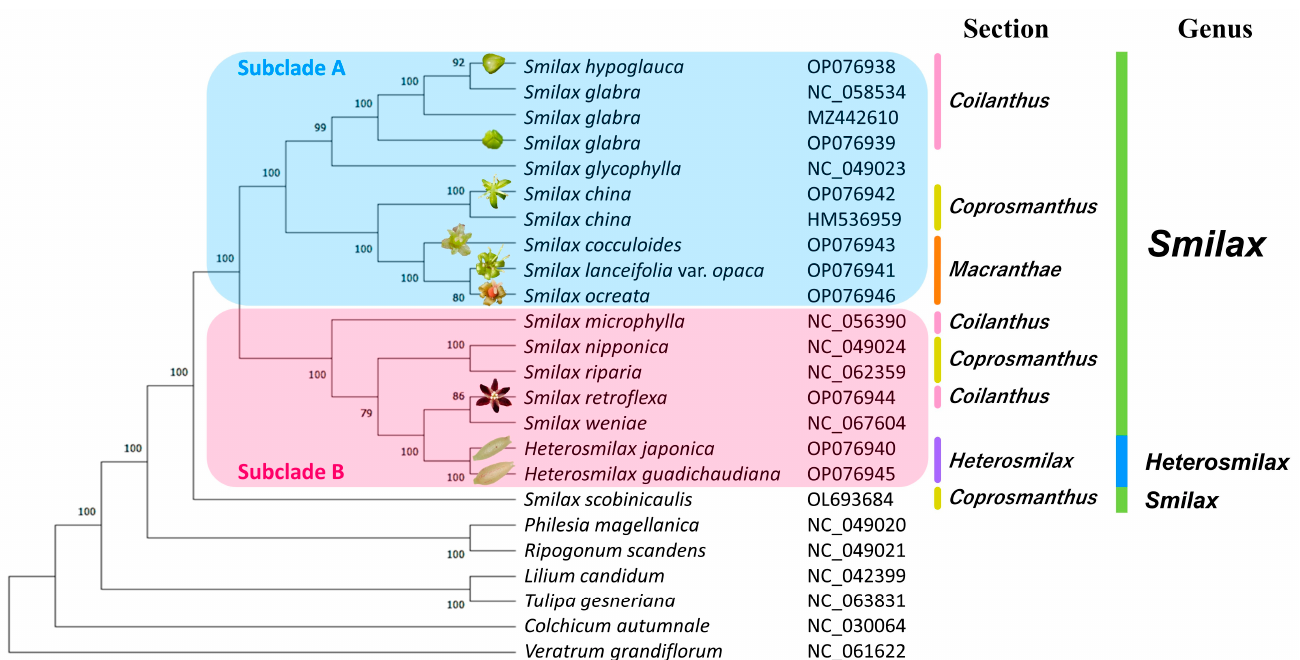
Figure 8. Phylogenomic analysis of eighteen Smilacaceae cpGenomes. The accessions of Colchicum autumnale (NC_030064), Lilium candidum (NC_042399), Philesia magellanica (NC_049020), Ripogonum scandens (NC_049021), Tulipa gesneriana (NC_063831), and Veratrum grandiflorum (NC_061622) were included as an outgroup. The bootstrap percentage (BP) is shown next to the node of branches. The section-level classification was referred to that of Flora Reipublicae Popularis Sinicae (FRPS). Accessions with flower images were newly assembled in this study. The flower images of the studied nine species were taken by T. Y. Siu and K. H. Wong, except for that of S. ocreata , which was taken from the Hong Kong Plant Database, AFCD, the Government of HKSAR (hyperlink: https://www.her-